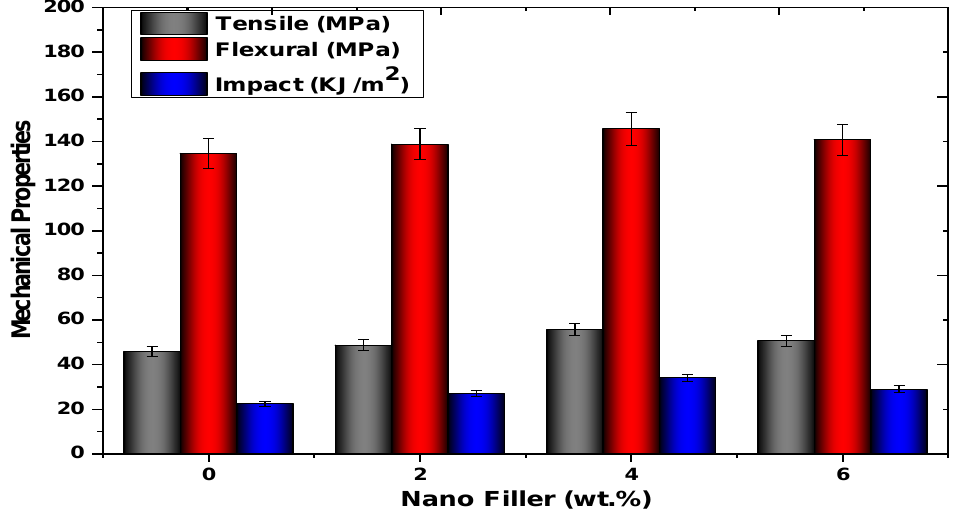
Figure 10. The average values of mechanical strength based on nano Al 2 O 3 particles.